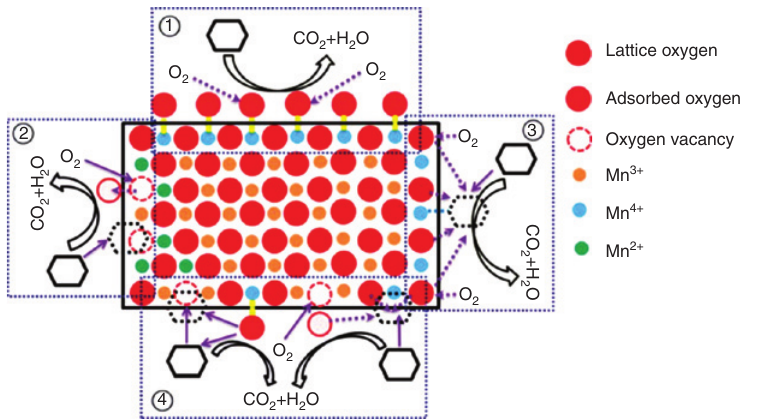
catalyst. Reproduced from [128] with permission from the Royal x